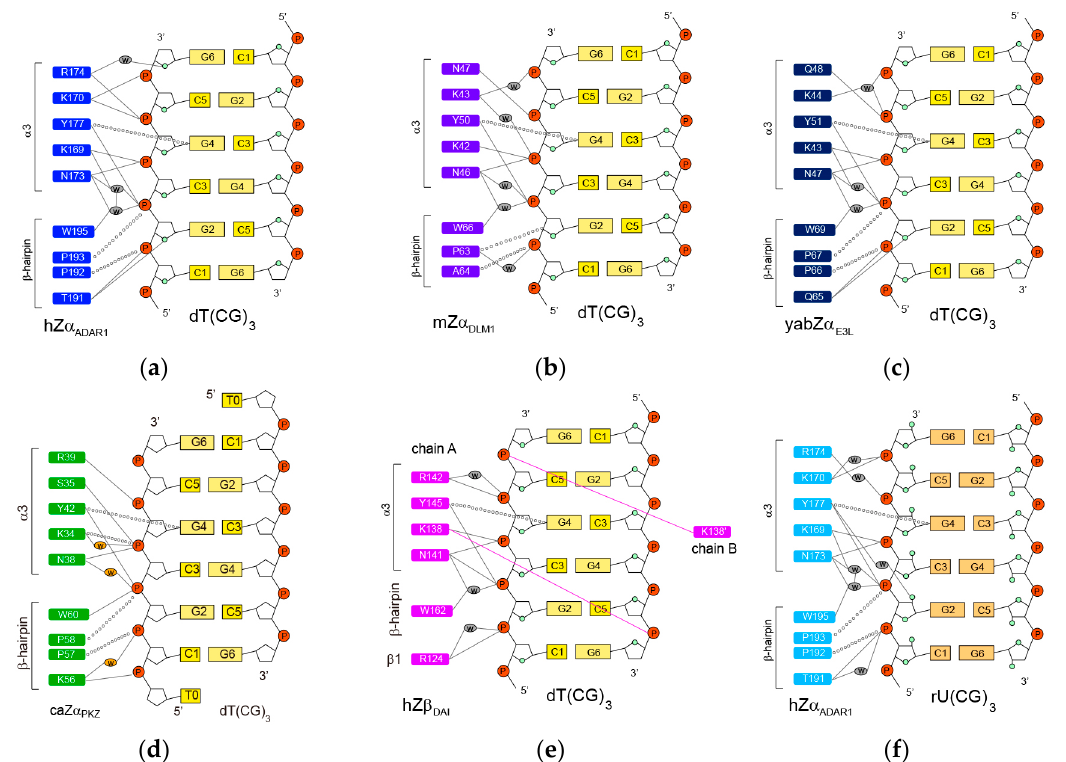
Figure 2. Protein residues involved Z-DNA/Z-RNA interactions in ( a ) hZ α ADAR1 –dT(CG) 3 [7], ( b ) mZ α DLM1 –dT(CG) 3 [29], ( c ) yabZ α E3L –dT(CG) 3 [30], ( d ) caZ α PKZ –dT(CG) 3 [31], ( e ) hZ β DAI –dT(CG) 3 [32], and ( f ) hZ α ADAR1 –rU(CG) 3 complexes [33]. Intermolecular H-bonds and van der Waals contacts are indicated by solid lines and open circles, respectively. The water molecules in key positions within the protein–DNA interface are indicated by ovals.